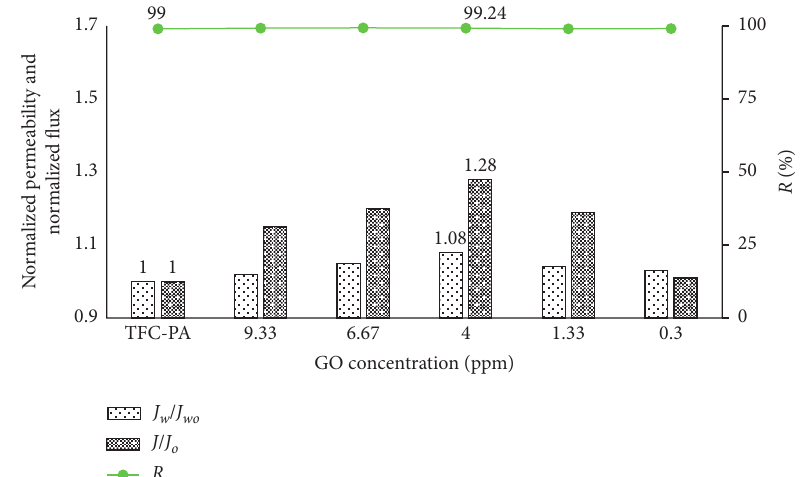
Figure 5: Normalized permeability and normalized flux of the uncoated and GO-coated membranes.